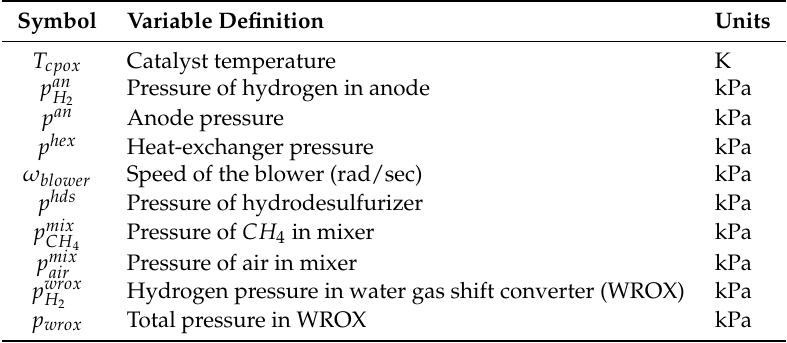
Table 2. Fuel processing system